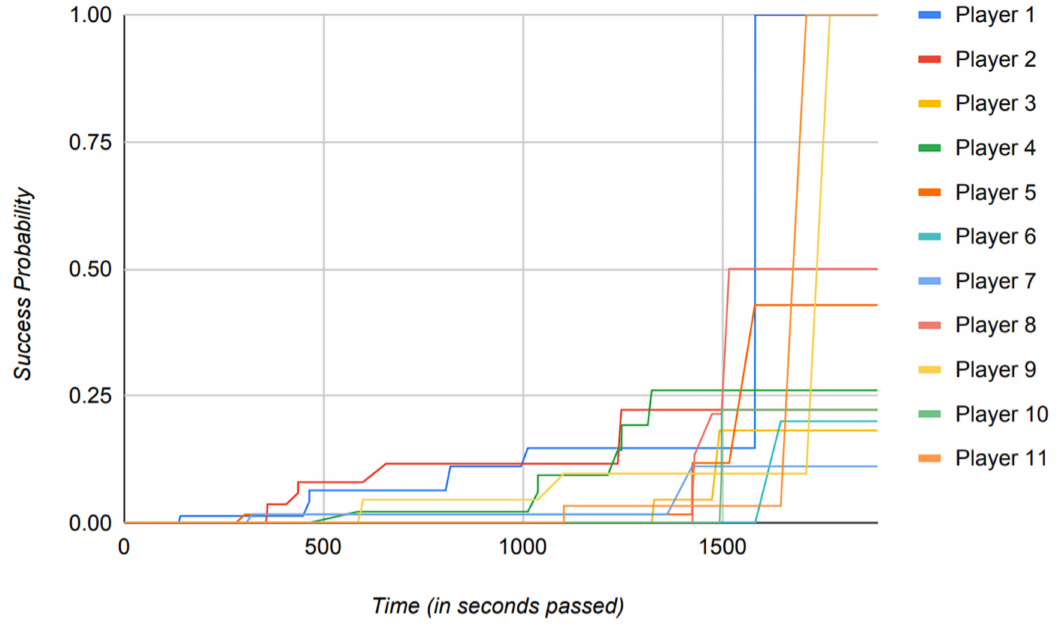
Figure 17. Success probabilities of top ~11% of players from a set of 99 players from a match of